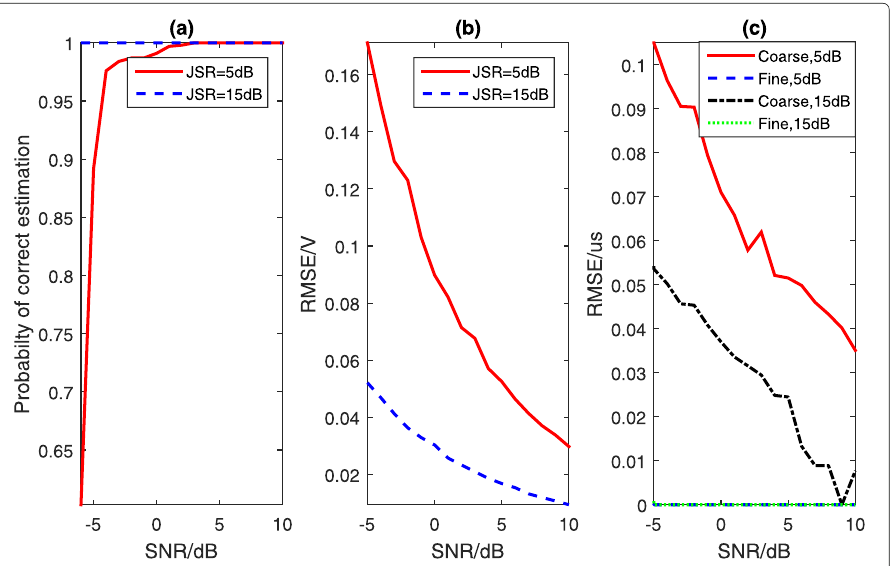
Fig. 5 The estimation performance of different parameters when JSR is 5dB and 15dB separately. a The probability of correct estimation to the number of sub-waveforms. b The RMSE of the amplitude. c The RMSE of coarse estimation and fine estimation to the time